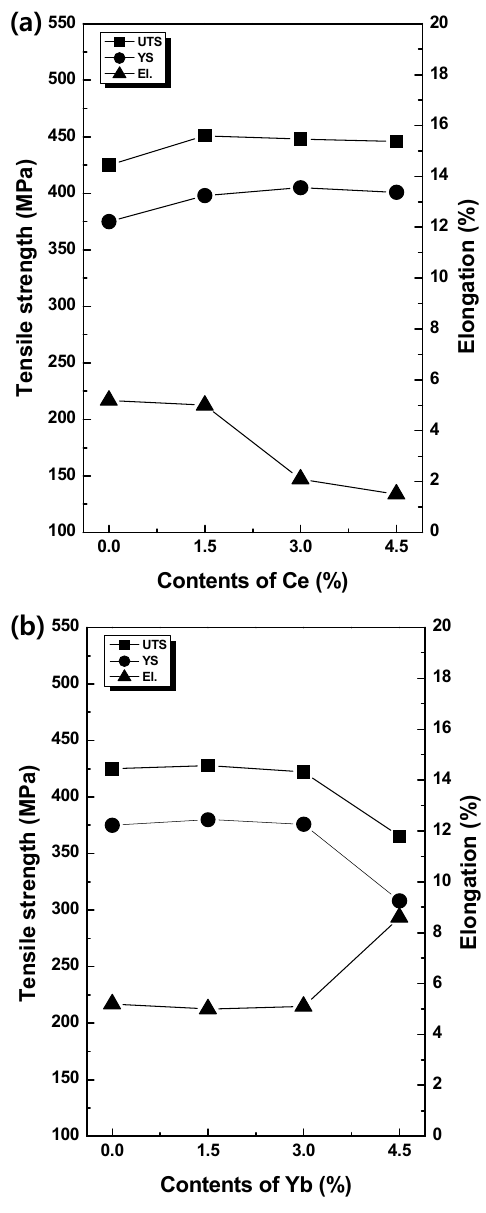
Figure 6. Mechanical properties of the extruded alloys at room temperature: ( a ) Mg-Zn-Y-Ce alloys; ( b ) Mg-Zn-Y-Yb alloys.